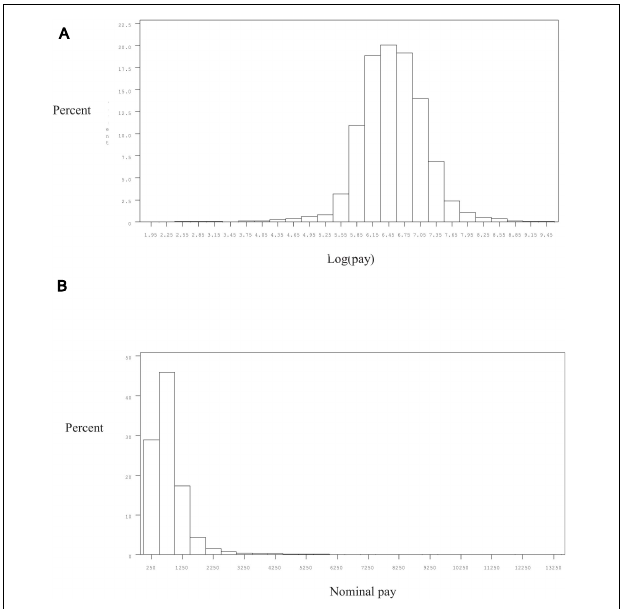
FIGURE 3 | (A) The distribution of log pay in 1994. (B) The distribution of nominal pay in